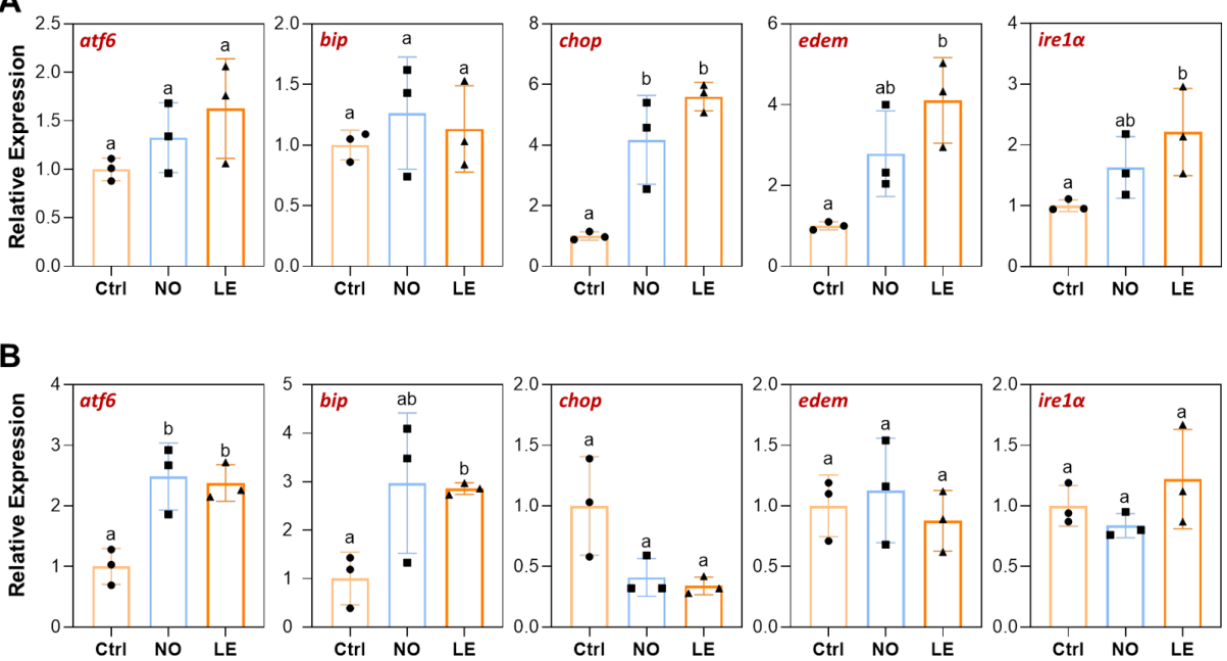
Figure 7. Expression of the ER stress-response-related genes determined by qPCR. ( A ) Brain. ( B ) Liver. The error bars represent SD ( n = 3). The dots, squares and triangles represent data of the corresponding experimental groups shown in the horizontal axis. Different letters above the error bars indicate significant difference between the means ( p ≤ 0.05 ).